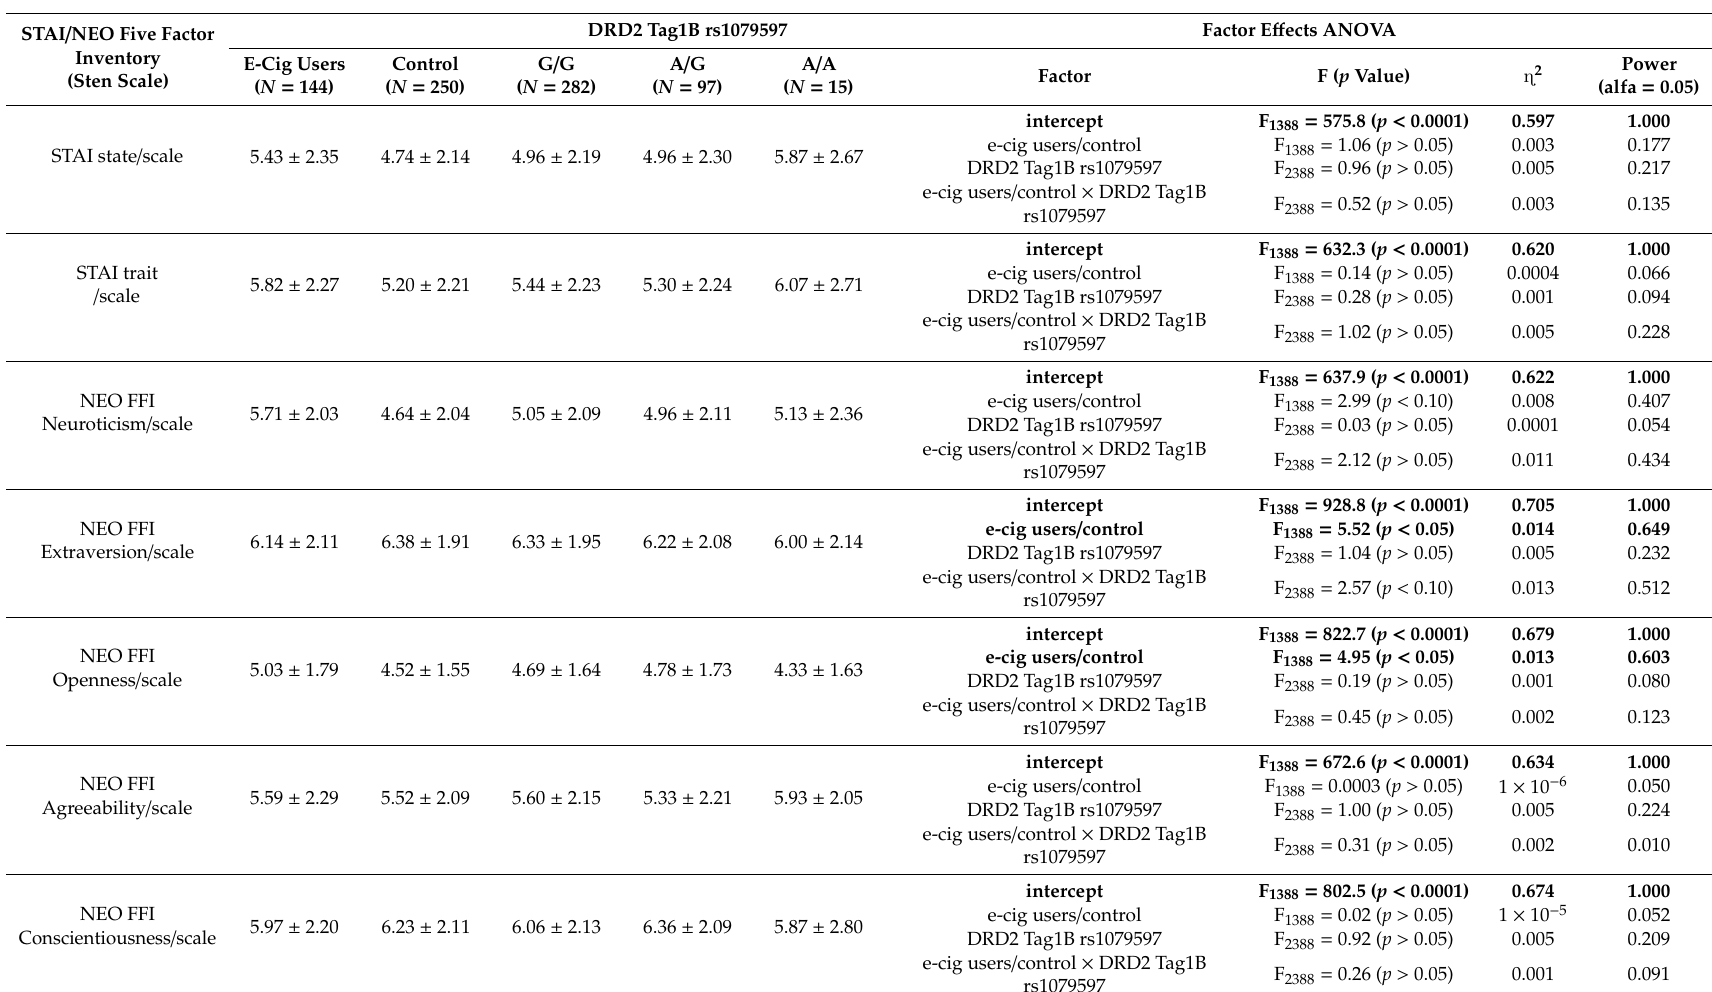
Table 4. Di ff erences in DRD2 Tag1B rs1079597 and STAI / NEO Five Factor Inventory between control subjects and e-cigarette